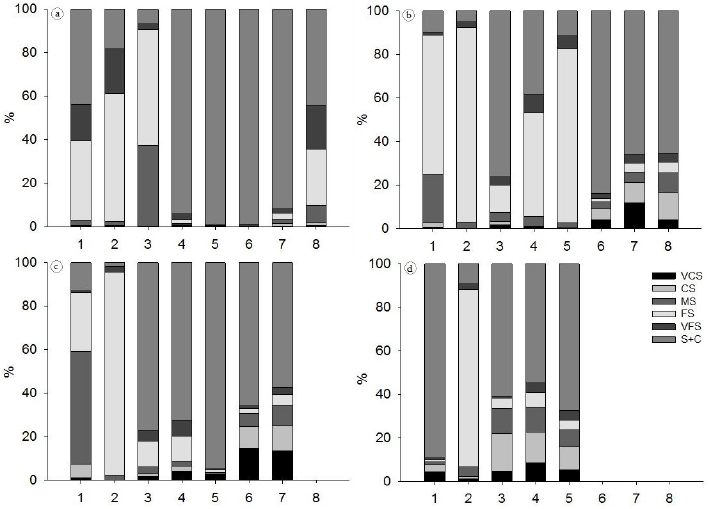
Figure 4. Sediment composition at the eight sampling sites (1-4: Guareí River; 5-8: lateral area) in October (2013) (a), January (b), April (c) and July (d) (2014) (VSC: very coarse sand; CS: coarse sand; MS: medium sand; FS: fine sand; VFS: very fine sand and S + C: silt and clay). Table 1. Differences in environmental variables and sediment composition determined by ANOVA (F and p) and Student t-test (T and p) between sampling months (October, January, April and July) and sites along the Guareí River (1-4) and in the lateral area (5-8) and contrasts by Tukey test (significant differences in bold). Environmental F and T Tukey Sediment F and T P variables values contrasts composition